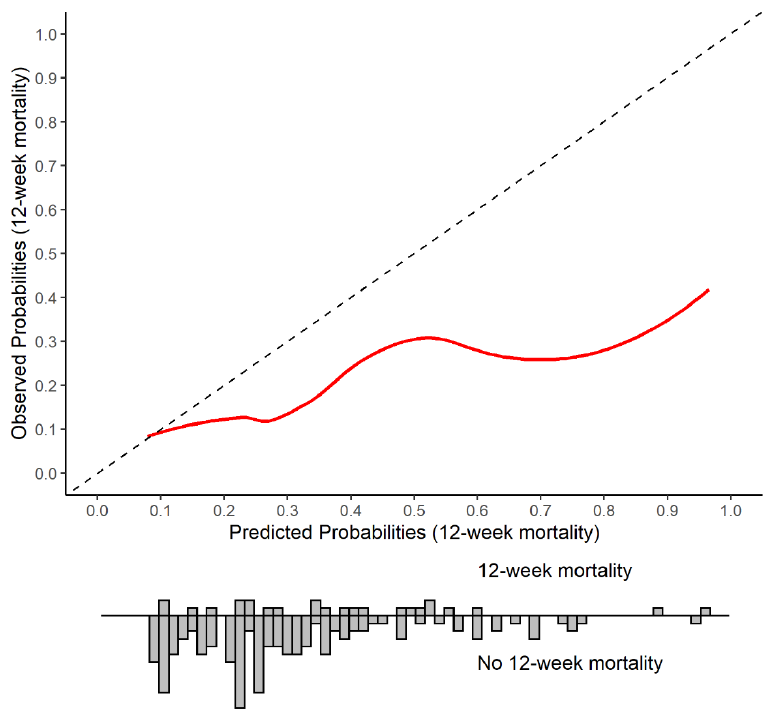
Figure 2. Calibration plot of the Colon Life nomogram: predicted versus observed 12-week mortality in QUALITAS patients. The Colon Life nomogram predicted 12-week mortality versus the observed 12-week mortality is shown, with the diagonal line indicating performance of a well-calibrated model. The histogram displays the predicted probability distribution for patients who died within 12 weeks of initiating FTD/TPI treatment versus who survived.